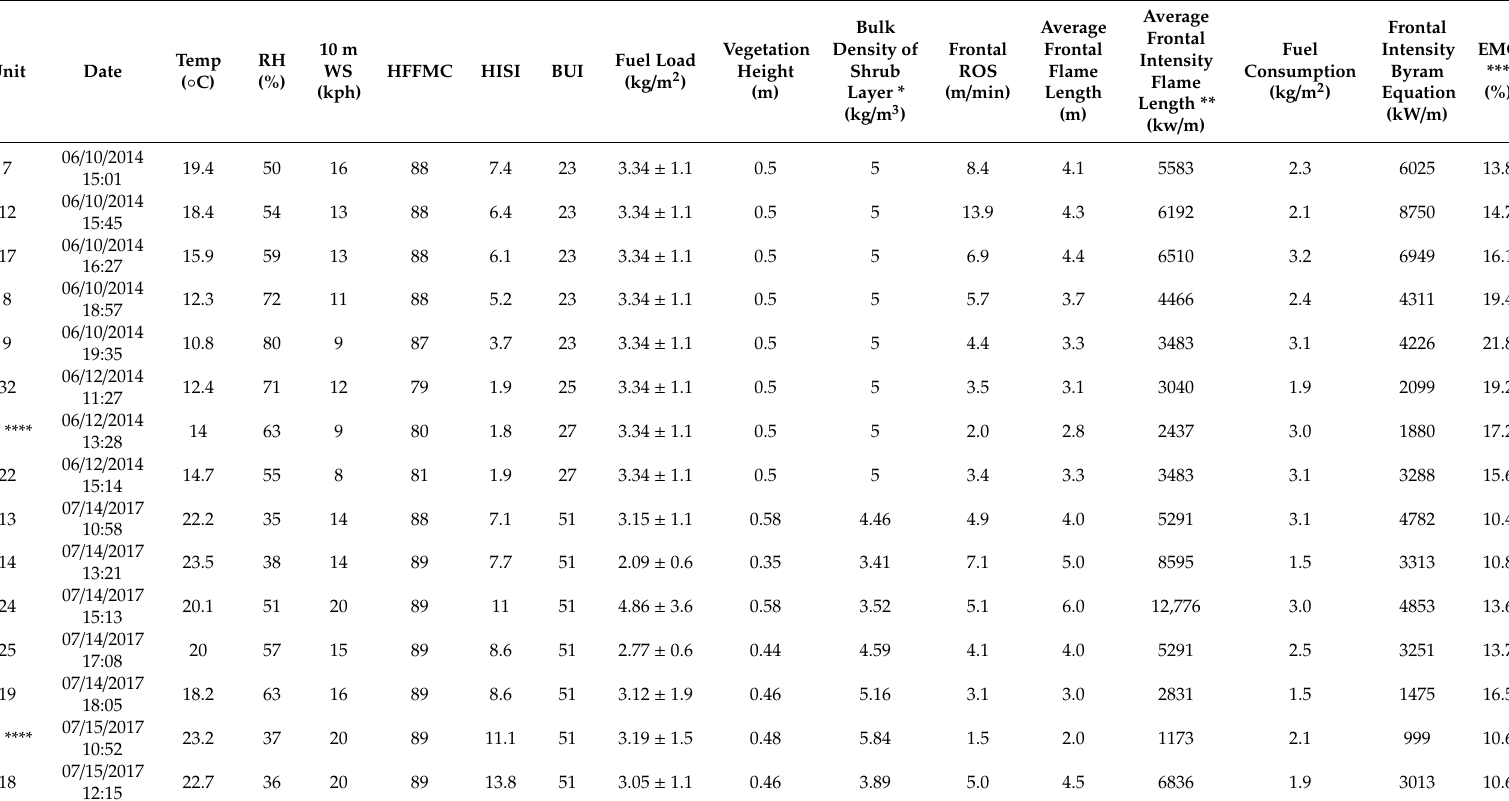
Table 1. Canadian Forest Weather Index (FWI) System component values associated with fifteen 0.04 ha experimental fires (2014–2017) along with corresponding fuel and fire behaviour